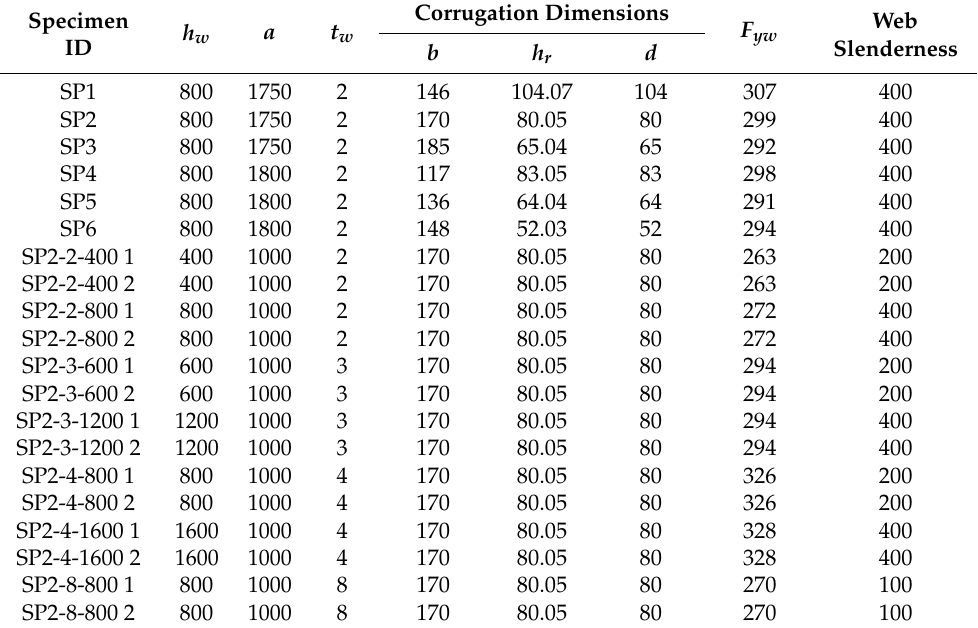
Table A4. Data of specimens tested by Peil [27].